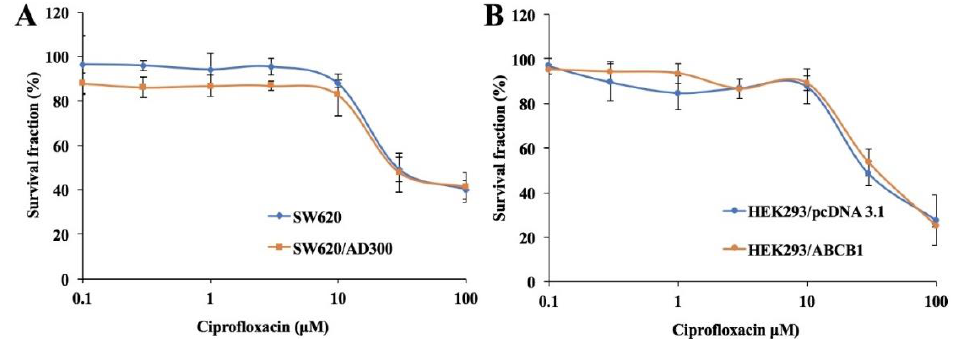
Figure 1. Cytotoxicity of ciprofloxacin in parental and drug-resistant cells. Cell survival (%) percentage was measured after treatment with ciprofloxacin for 72 h in parental and drug-resistant cells: SW620 and SW620/AD300 cells ( A ), HEK293/pcDNA3.1 and HEK293/ABCB1 cells ( B ). Points with error bars represent the mean ± SD for independent determinations in triplicate. The above figures are representative of three independent experiments.